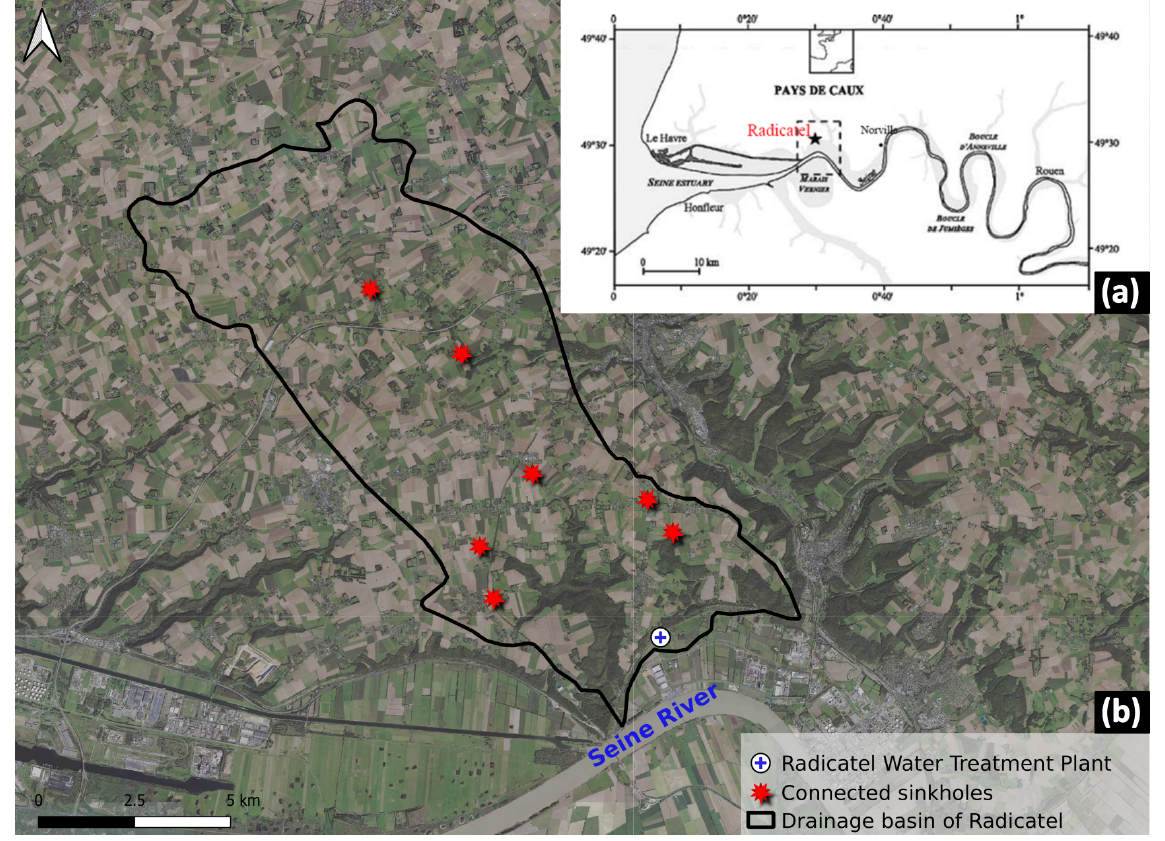
Figure 1. (a) Location of the study site in the lower Seine Valley (Normandy, France) on the right bank of the Seine River (Hanin, 2011) and (b) location of the water treatment plant of Radicatel and the seven connected sinkholes. The background map was retrieved from BD Ortho ©